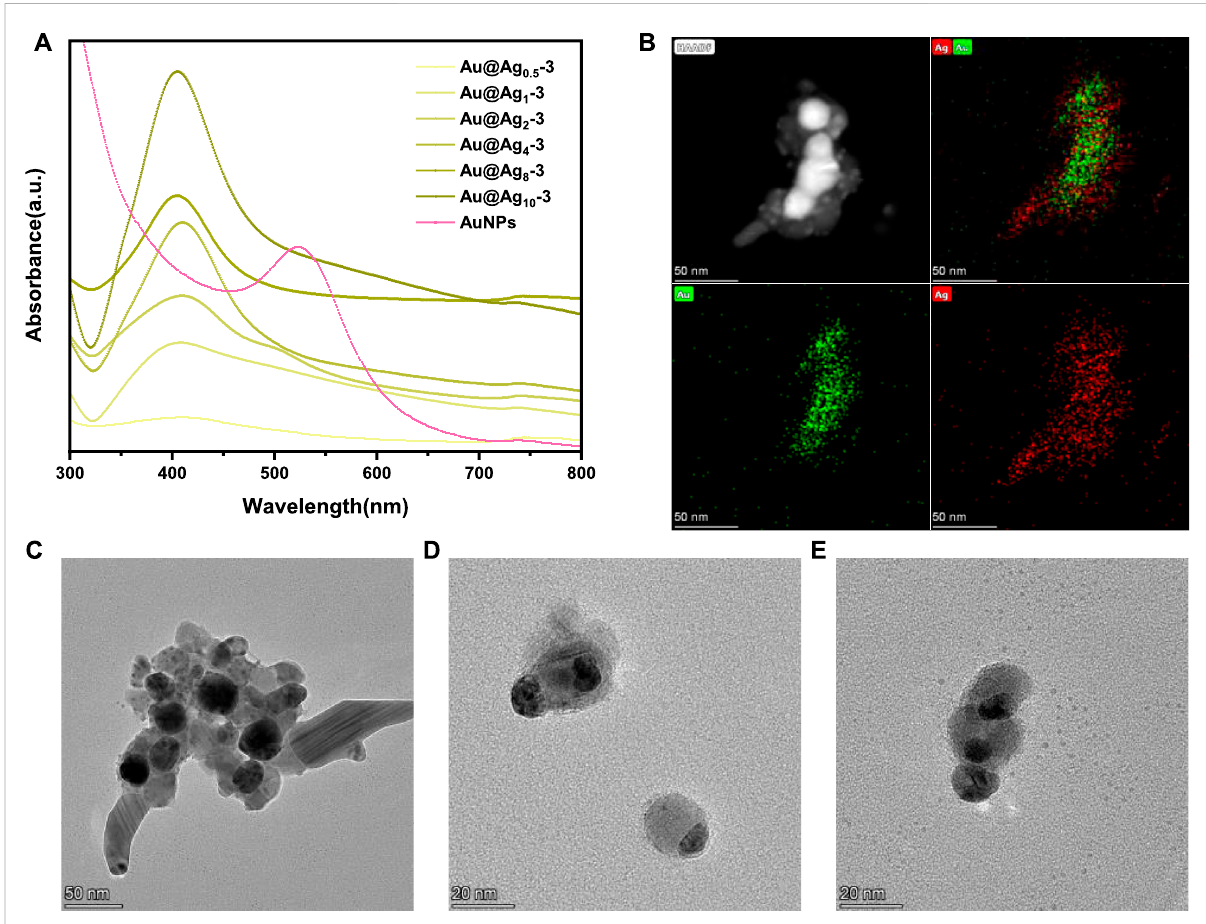
FIGURE 6 (A) UV-vis spectra of the nanoparticles on Au-Ag m -3-FP, (B) STEM dark- fi eld picture and EDS mapping pictures of nanoparticles on Au-Ag 8 -3- FP, (C) , (D) , (E) TEM images of nanoparticles on Au-Ag 8